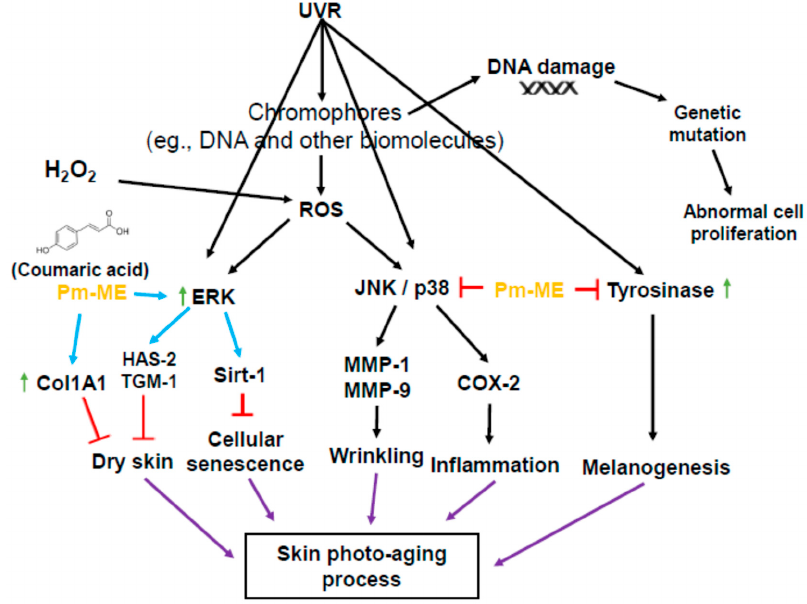
Figure 6. Schematic summary of the Pm-ME-mediated skin-protective pathway.